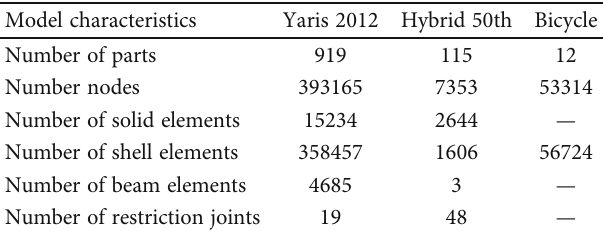
Table 2: Toyota Yaris 2012 and Hybrid III 50th percentile characteristics [20,